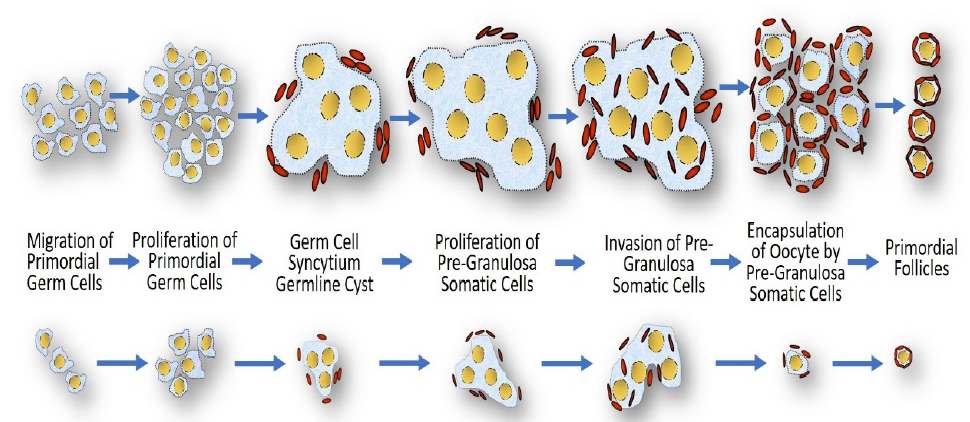
Figure 4. The process of development of the primordial follicle under the hypothesis of the prolonged cell cycle. After arrival at the gonads, the primordial germ cells form germline cysts. During this process, the pregranulosa cells proliferate by mitotic division to surround germ cells. Then, the first oogonia within the germline cysts enter meiosis and arrest at the end of prophase I. Later, the germline cysts are invaded by the pregranulosa cells to encapsulate oocytes and form primordial follicles. Both germ cells and pregranulosa cells need to enter successive cell divisions for proper assembly of primordial follicles to occur and to endow sufficient follicles for reproductive life. In Turner syndrome, a decrease in cell proliferation determines a decrease in the number of primordial cysts and inadequate assembly of the primordial follicles.